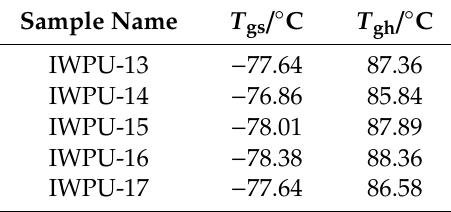
Table 6. T g of IWPU films.